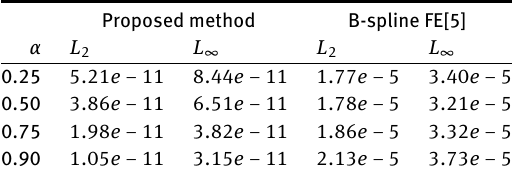
Table 8: The convergence rate of the proposed method to solve example